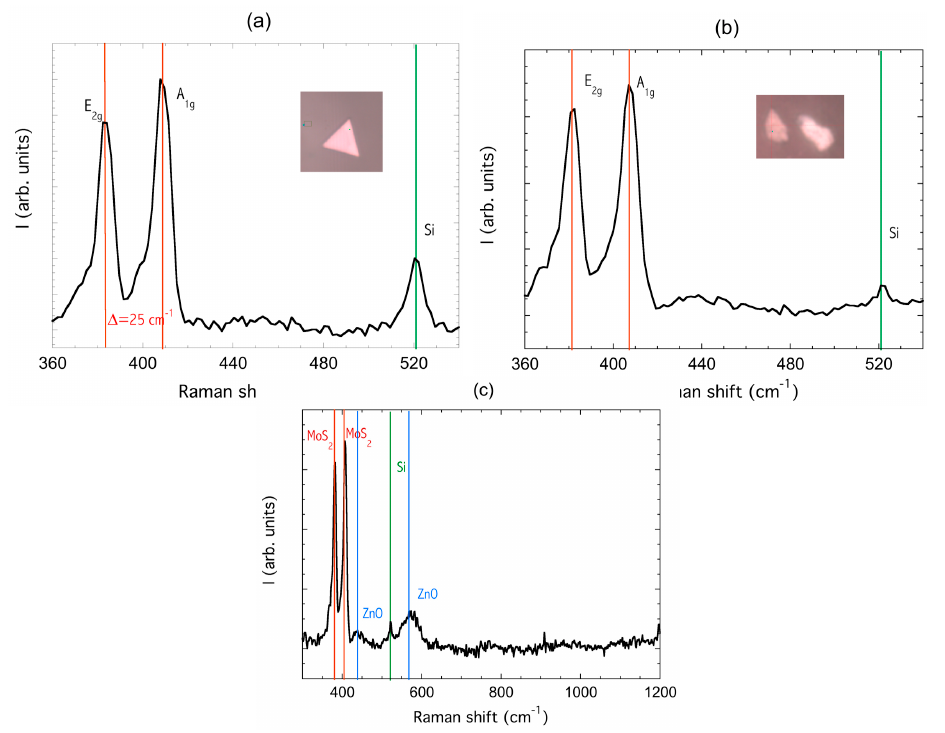
Figure 4. ( a ) Raman spectrum of the triangular MoS 2 flake reported in Figure 3a; ( b ) Raman spectrum of a ZnO / MoS 2 sample G prepared as reported in Table 1; ( c ) Raman spectrum of the ZnO nanorods of sample G.